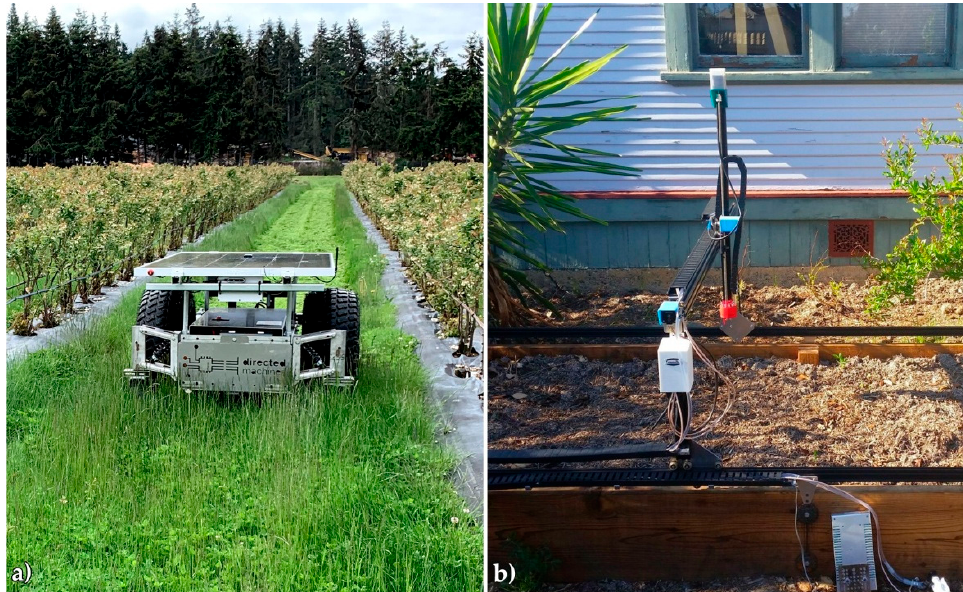
Figure 15. Autonomous machinery: ( a ) Directed Land Care Robot. Reproduced with permission from [59], 2020 Directed Machines; ( b ) FarmBot Genesis, photo by FarmBot, distributed under CC BY 4.0 license [63].